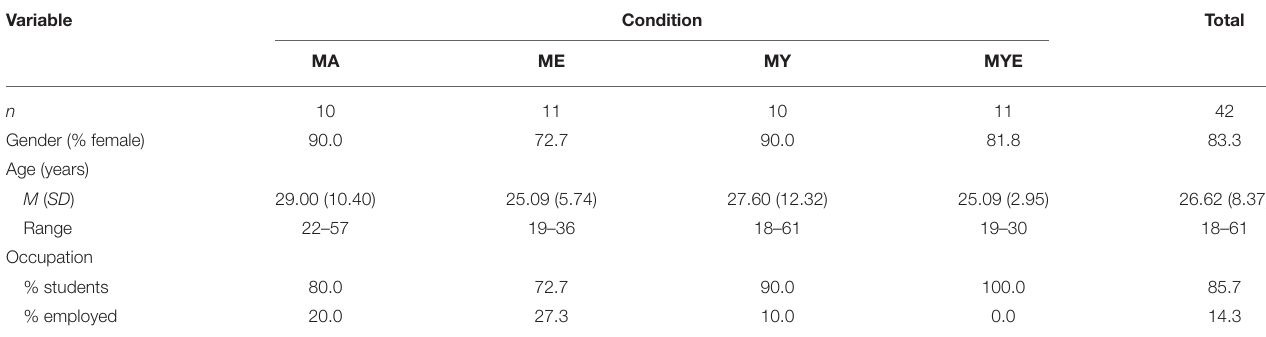
TABLE 1 | Sociodemographic data of participants in each